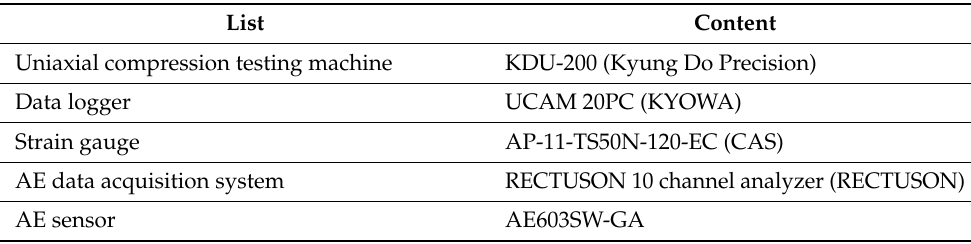
Table 2. Equipment specification for uniaxial compression and acoustic emission test.